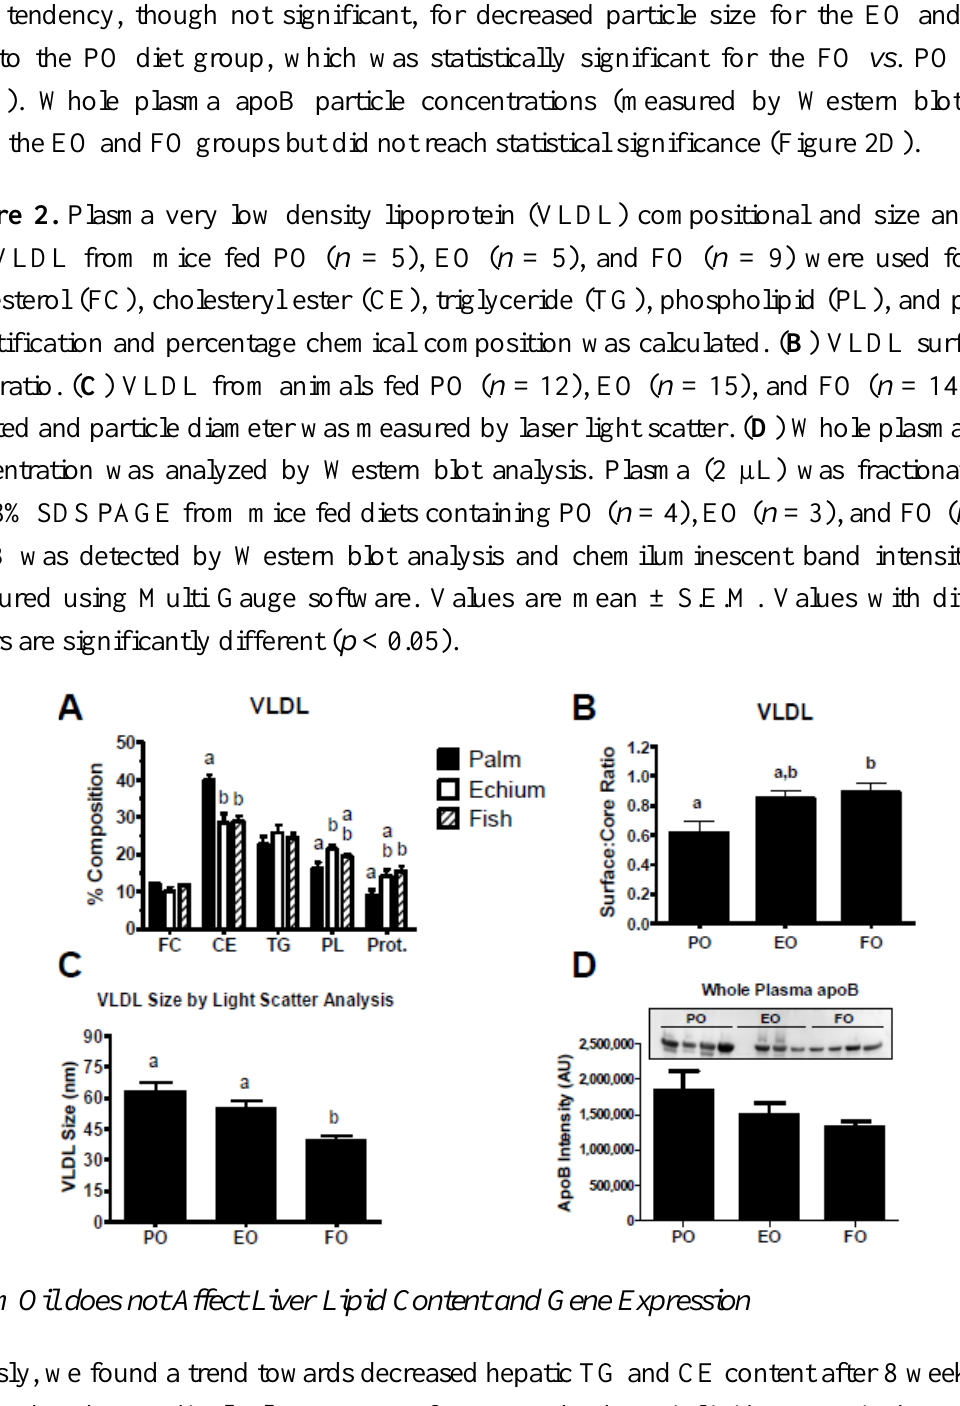
Figure 2. Plasma very low density lipoprotein (VLDL) compositional and size